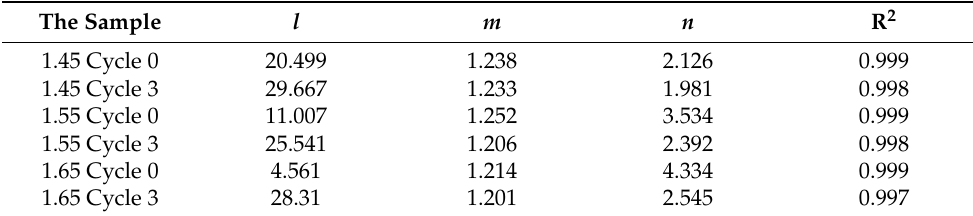
Table 4. Fitted parameters of the cumulative PSD of loess samples.